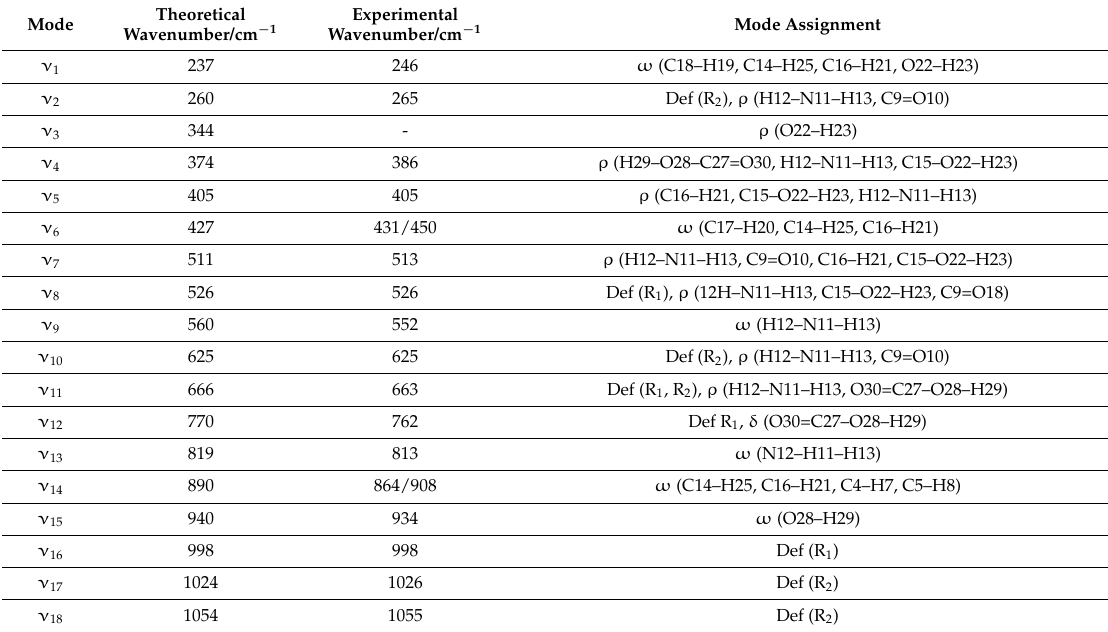
Figure 6. Comparison of Raman spectra between simulated ( a ) and experimental ( b ) results of the cocrystal between PZA and 3-hBA. Table 2. Vibrational modes assignment for Raman characteristic peaks of the cocrystal between PZA and 3-hBA.